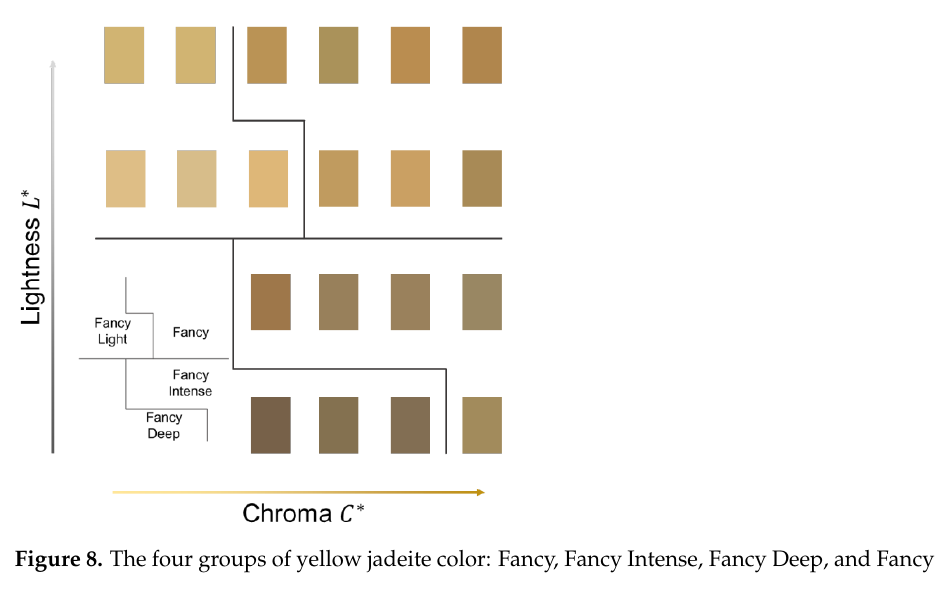
Figure 8. The four groups of yellow jadeite color: Fancy, Fancy Intense, Fancy Deep, and Fancy Light.